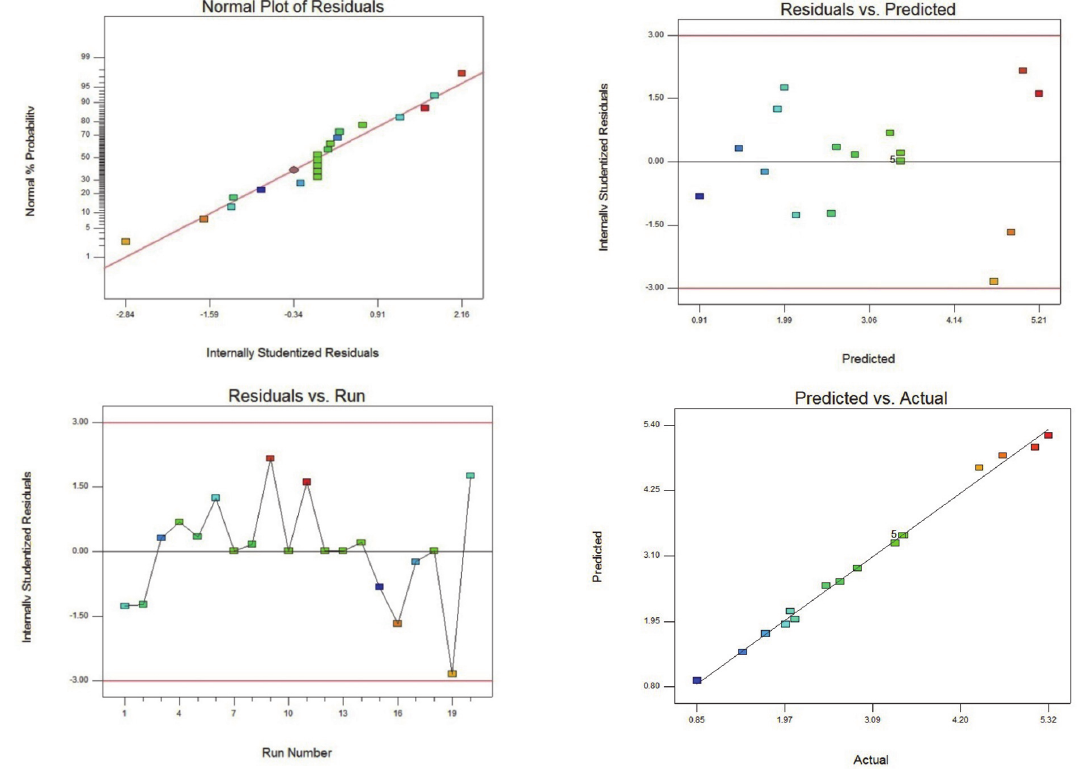
Fig. 5. Residual plots for surface roughness of post turning Al-Si alloy